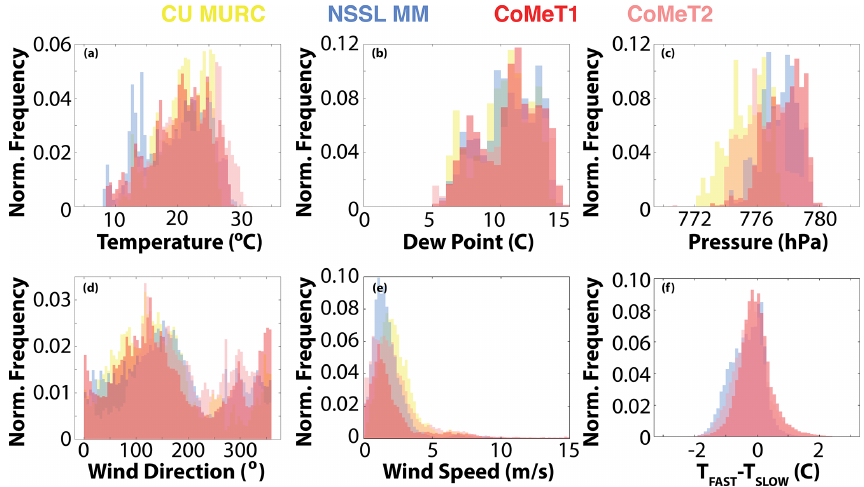
Figure 7. Distributions of 1min averages of data collected by the three platforms. Included are (a–f) distributions of air temperature, dew point temperature, pressure, wind direction, wind speed, and the difference between the fast and slow temperature sensors (where applicable). For all figures, CU MURC data are represented in yellow, NSSL MM data are represented in blue, and UNL CoMeT data are represented in red and pink.